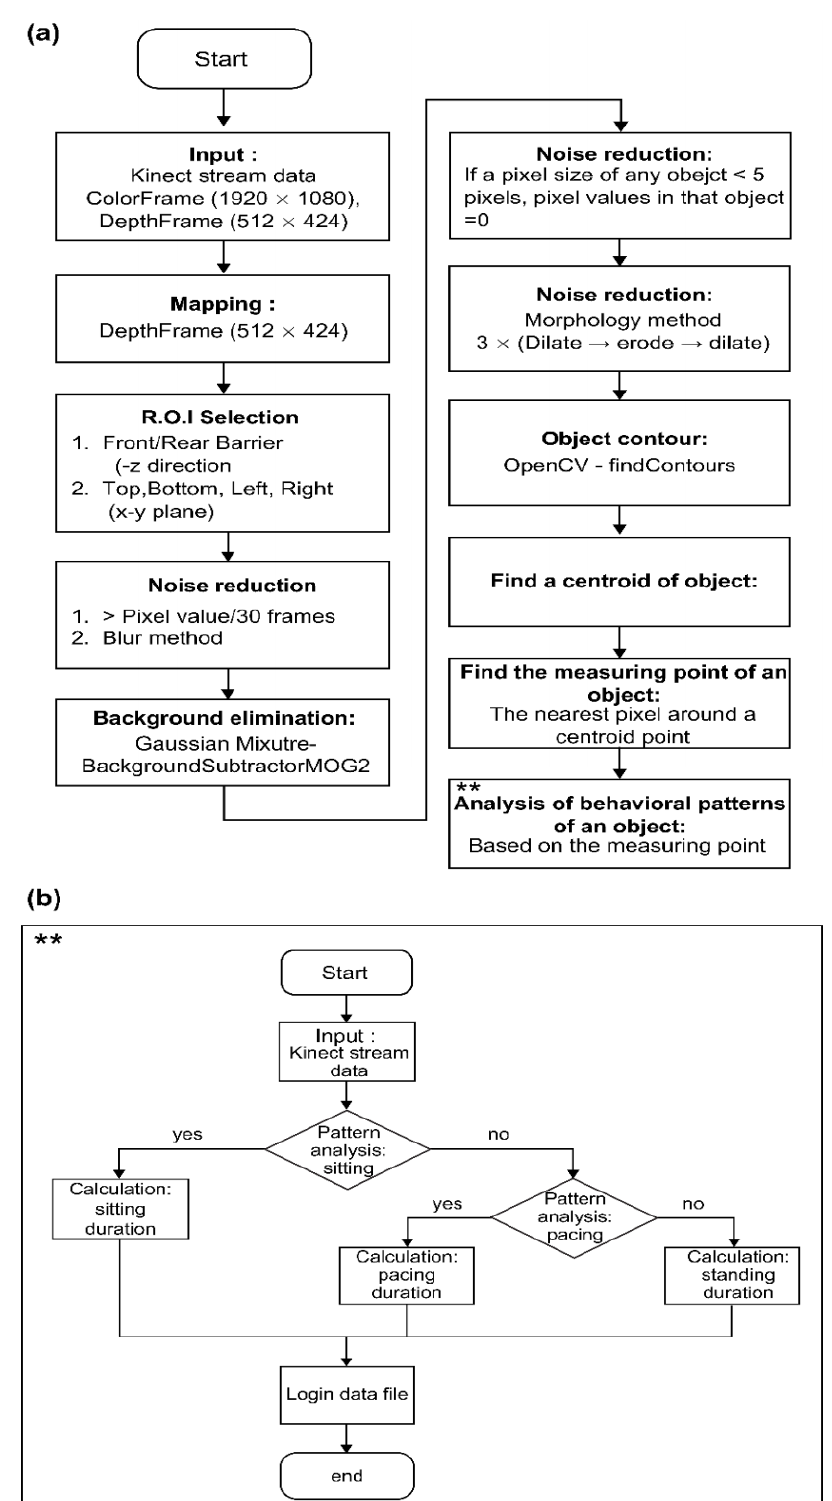
Figure 4. ( a ) Flow chart representing object contour creation, ( b ) Flow chart representing the behavioral pattern analysis. ** symbols in ( a ) and ( b ) indicate the process for the analysis of behavioral